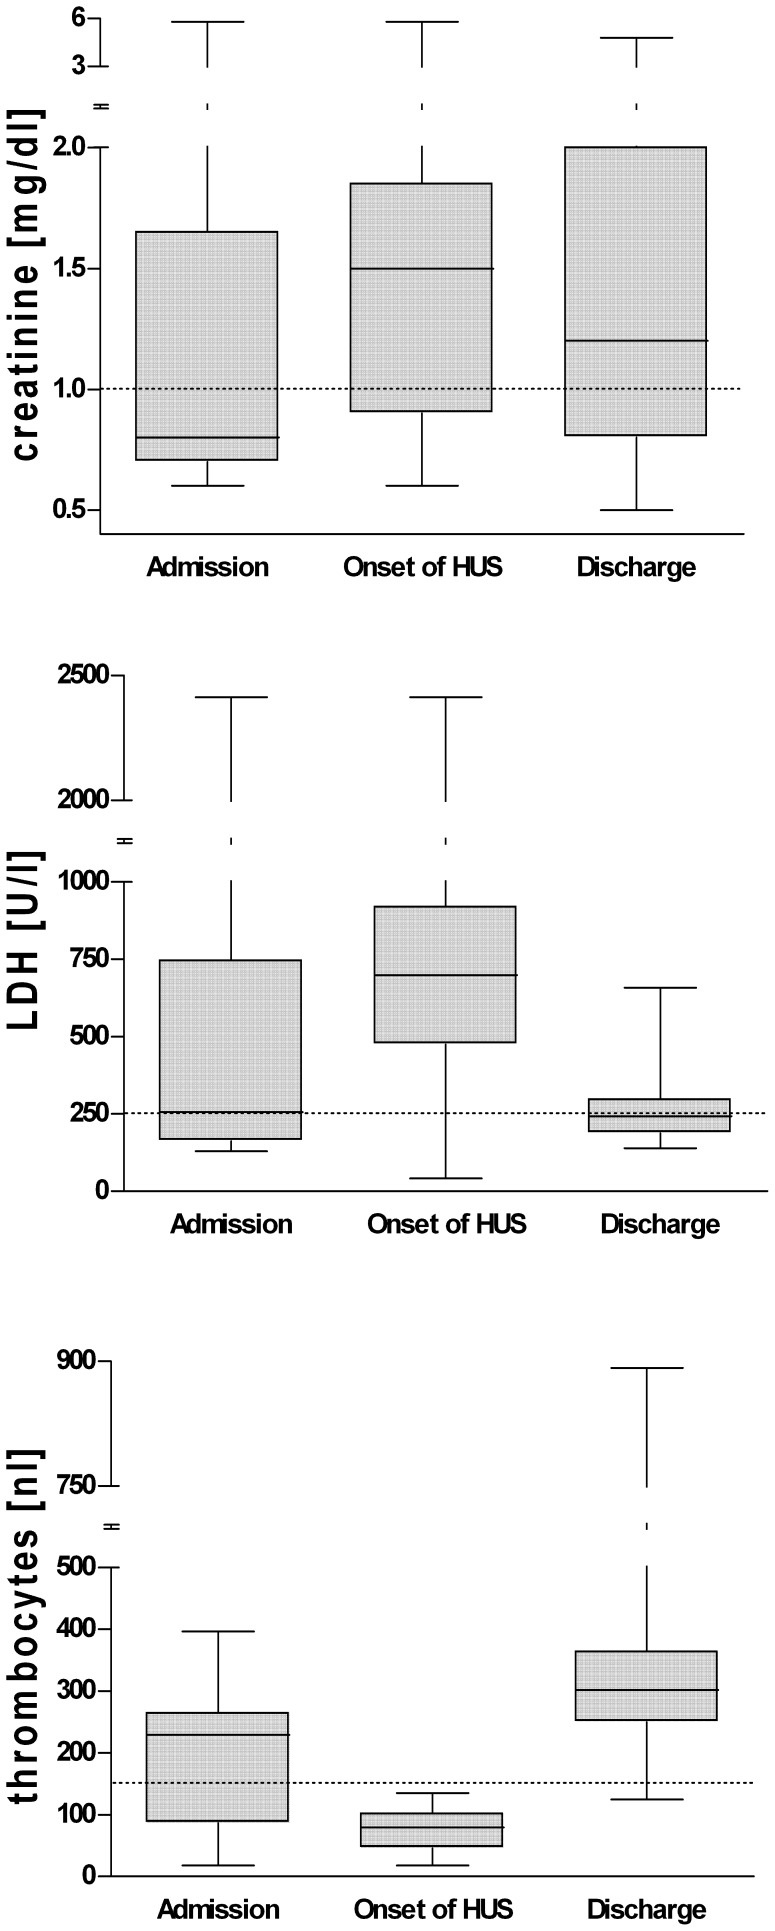
Development of serum creatinine, LDH, and thrombocytes in 36 patient suffering from HUS.[range, 25th–75th percentiles, median, reference levels].